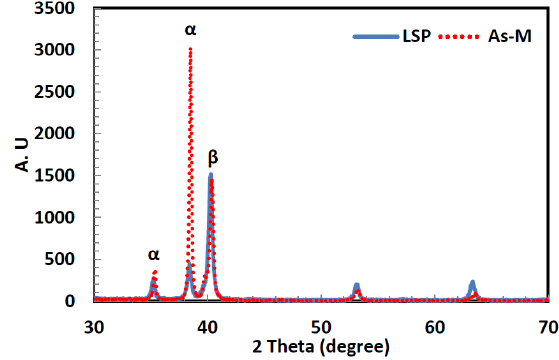
Figure 7. XRD patterns of the As ‐ M and LSP treated surface.